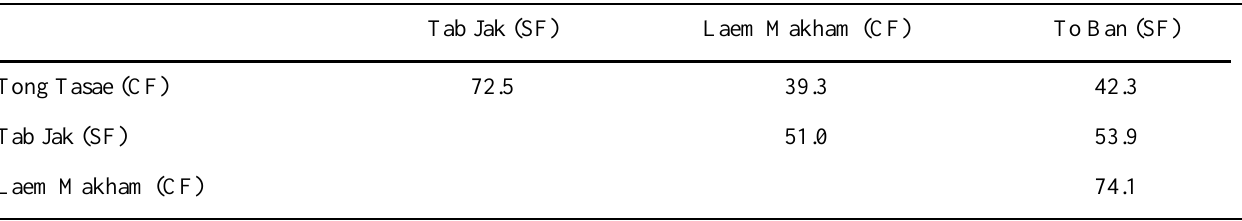
Table 5. Similarity of mangrove tree community composition across community-managed (CF) and state- managed (SF) mangrove forests in Trang, southern Thailand. Similarity was calculated using the Bray- Curtis Similarity Index (Bray and Curtis